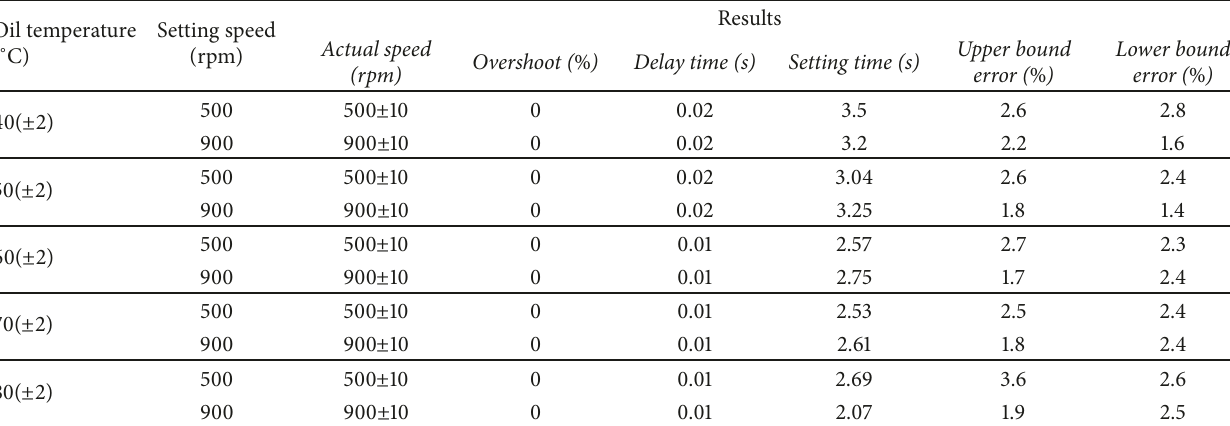
Table 6: Experimental results as a function of the oil